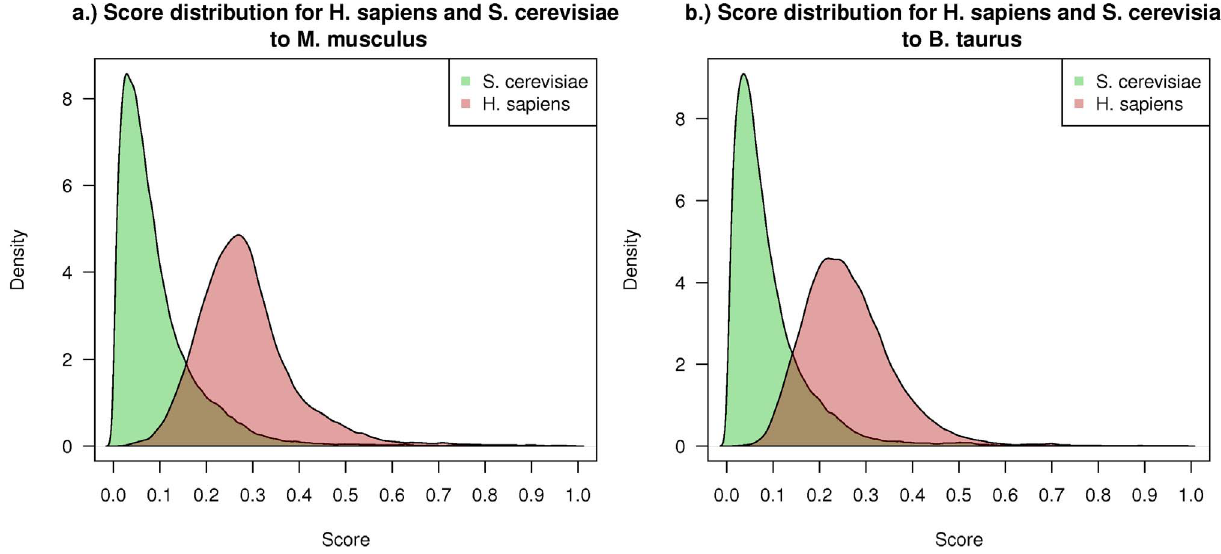
Figure 4. Score distributions. Score distributions for transferred interactions with RFF from S. cerevisiae and H. sapiens to the two target species ( a. ) M. musculus and ( b.) B. taurus . Transferred interactions from S. cerevisiae have significantly lower score values than transferred interactions from H. sapiens to both target species. With a low score threshold of 0.2 almost all interactions from H. sapiens will be transferred to the two target species whereas a huge fraction of the transferred S. cerevisiae interactions is filtered out.